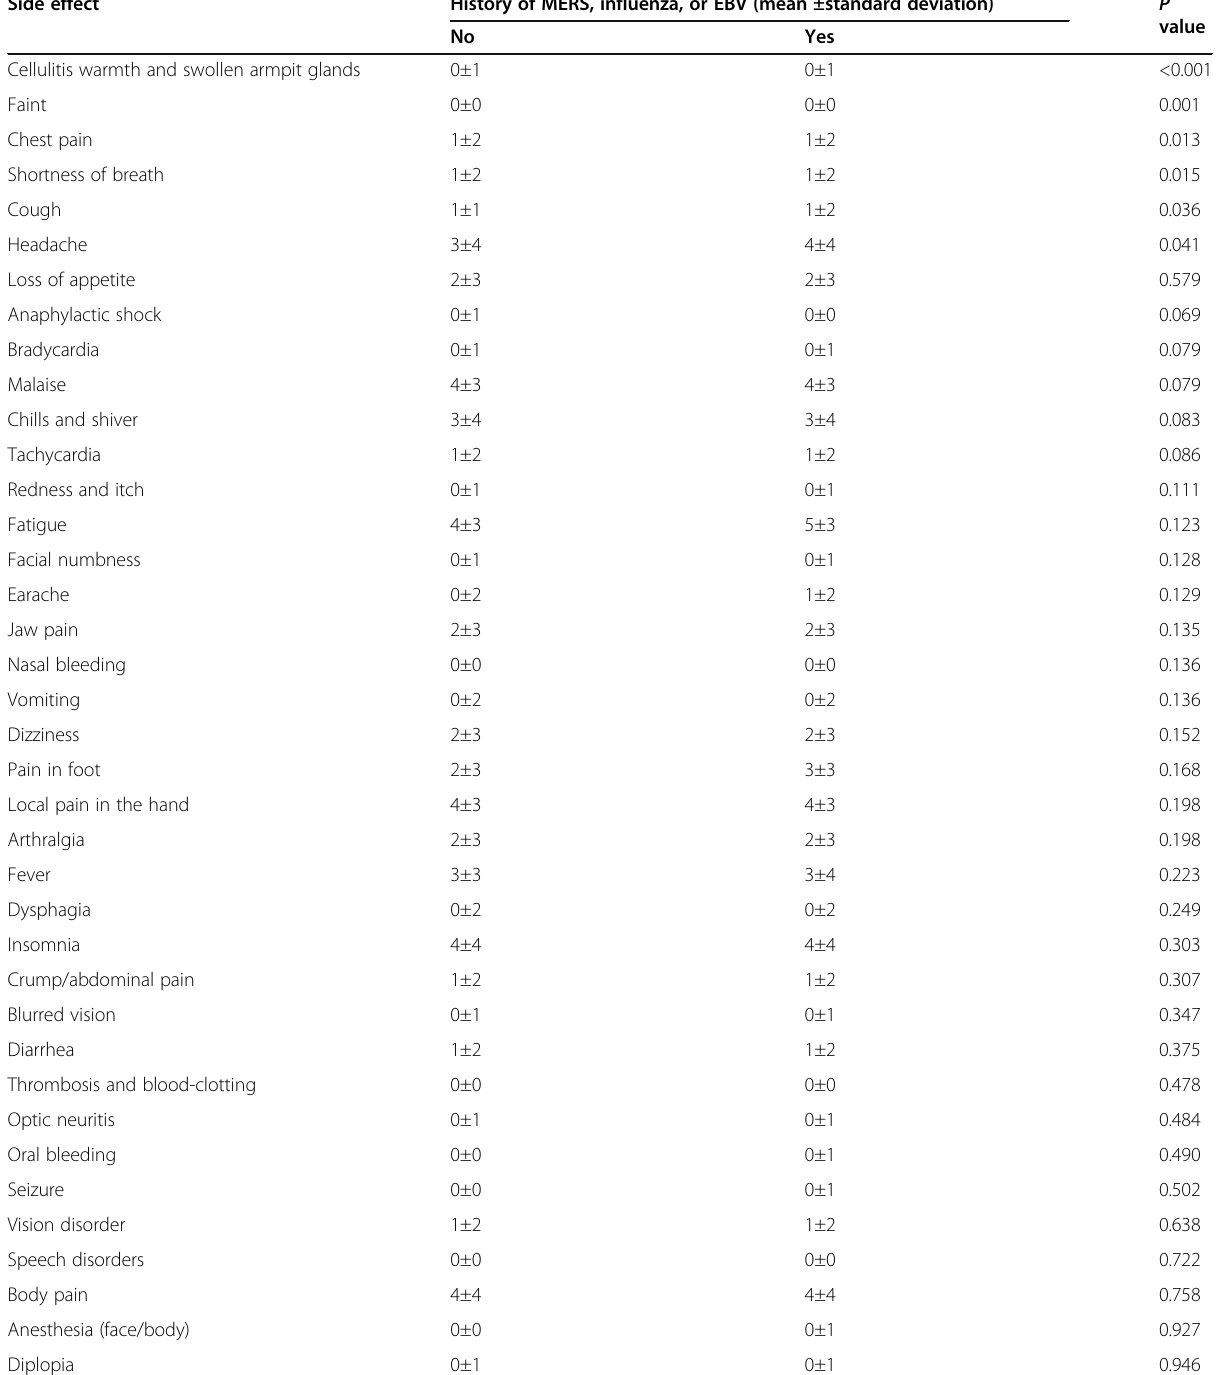
Table 4 The relationship between a history of MERS, influenza, or EBV and the intensity of side effects (on a 0 – 10 scale) Side